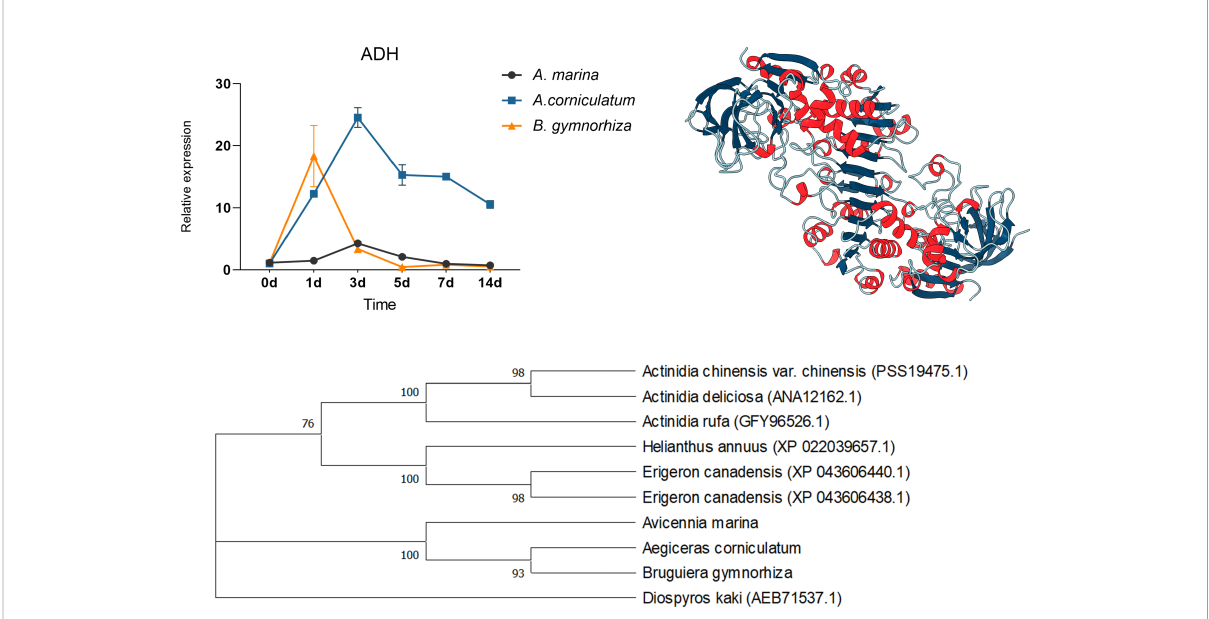
FIGURE 8 Quantitative expression of ADH s in three mangrove plants, 3D structure of AcADH, and phylogenetic tree of ADHs.